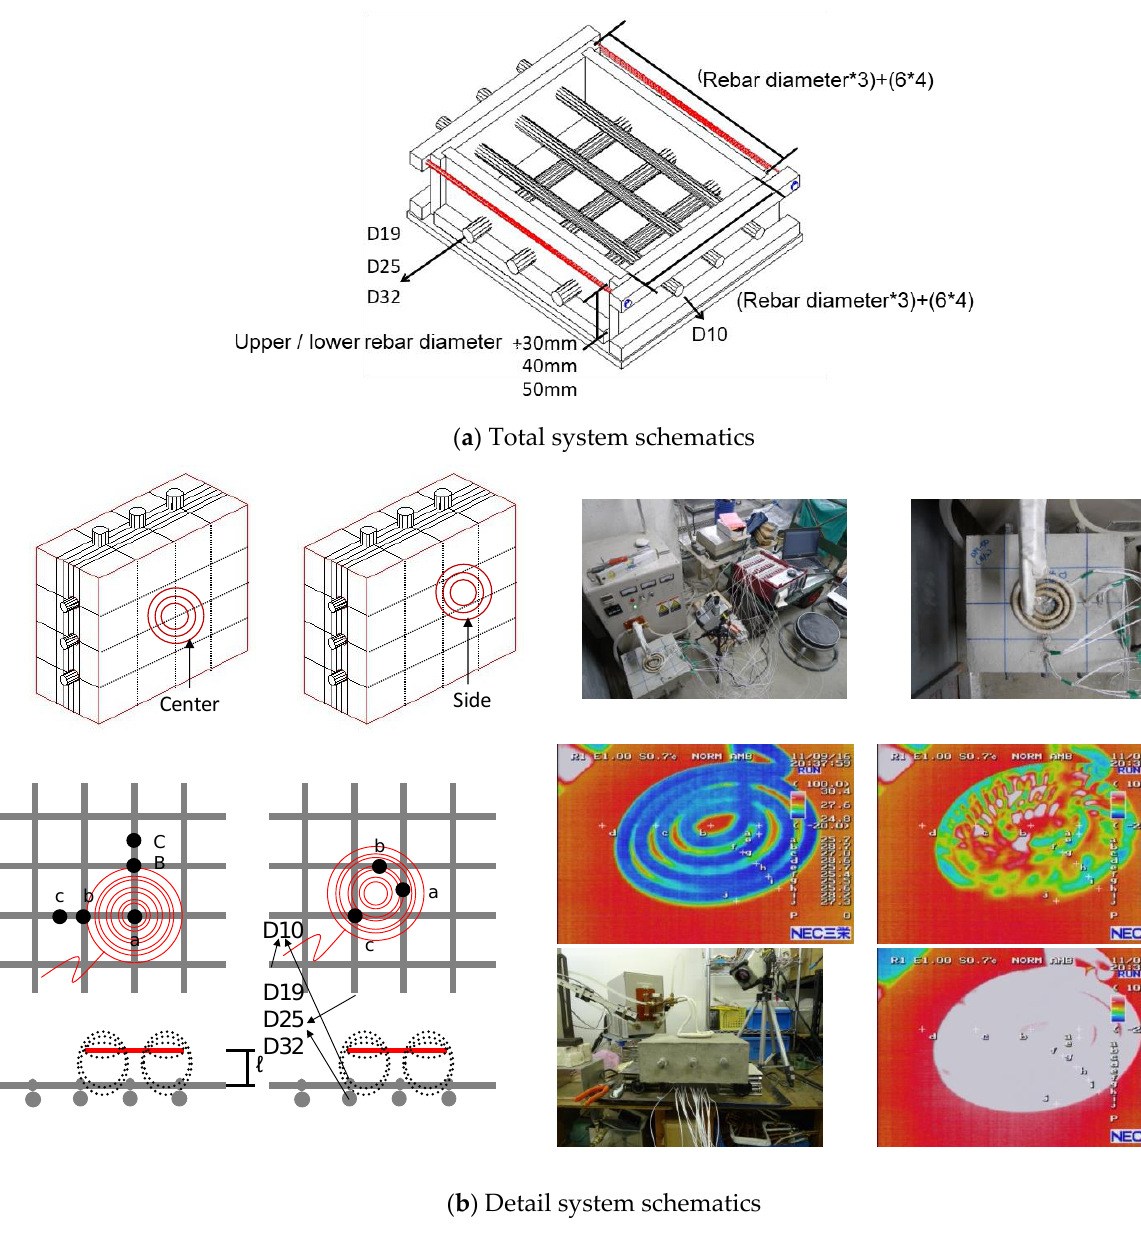
Figure 21. Test specimen production and control